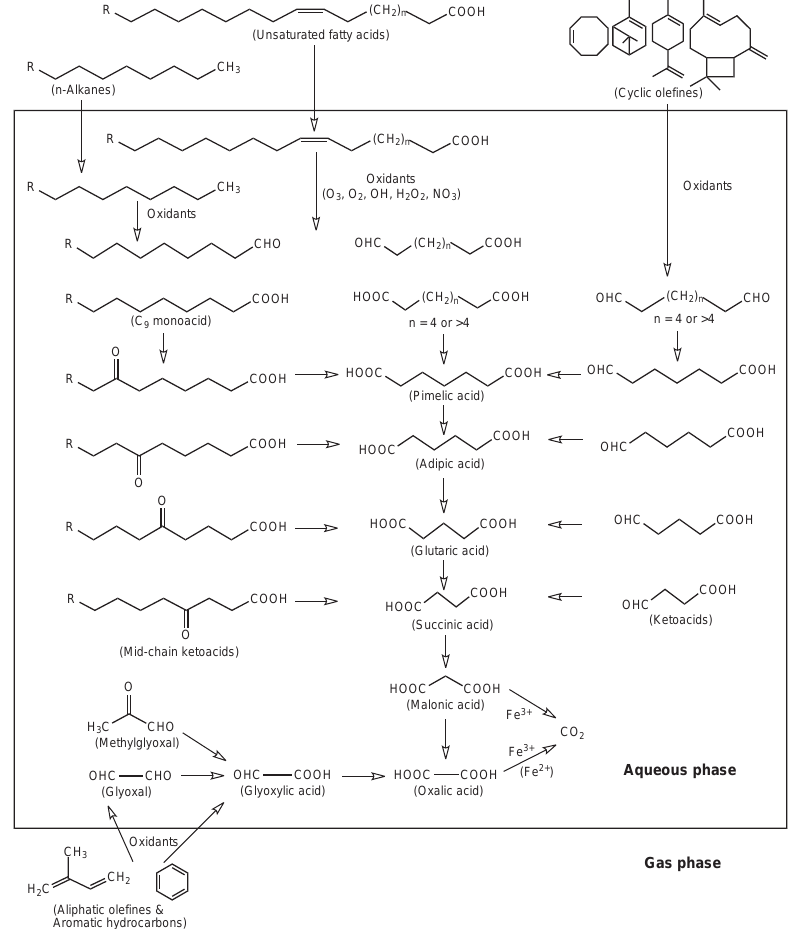
Figure 7. Possible photochemical formation and/or degradation pathways of diacids, oxoacids and α -dicarbonyls in aqueous